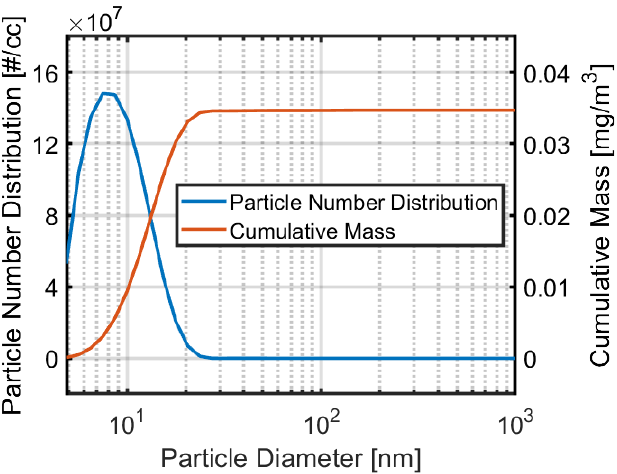
Figure 18. Particle number distribution and cumulative mass vs. particle diameter measured on a DMS 500 under lean, partially premixed operation at 10 bar IMEPn.